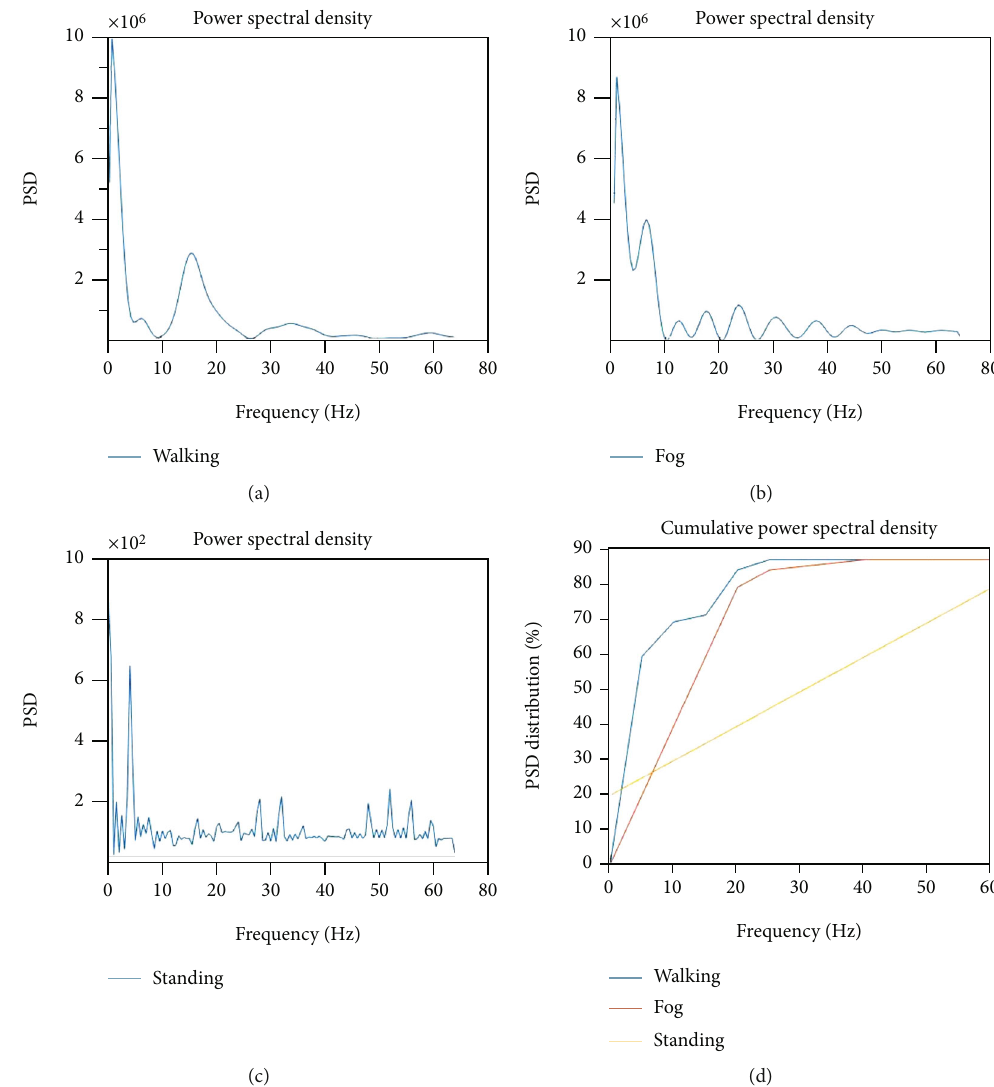
Figure 5: (a) (PSD) of signal (walking); (b) PSD of signal (FOG); (c) PSD (standing); (d) total power in the PSD (in